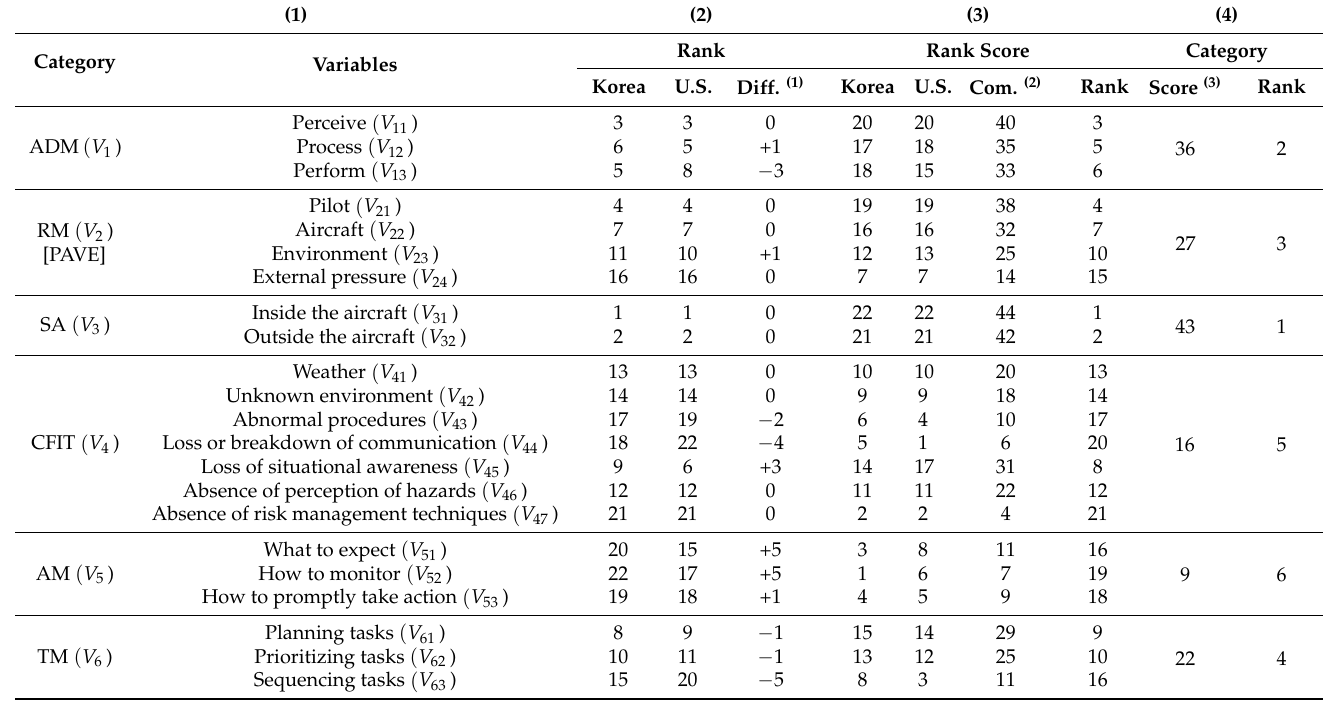
Table 6. Combined (Korea and U.S.) Variables and Category Ranks using Integral Fuzzy